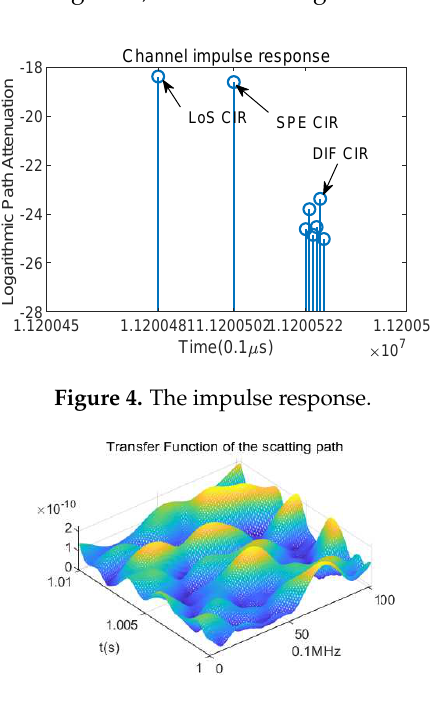
Figure 5. The time-frequency channel transfer function of the scattering path.